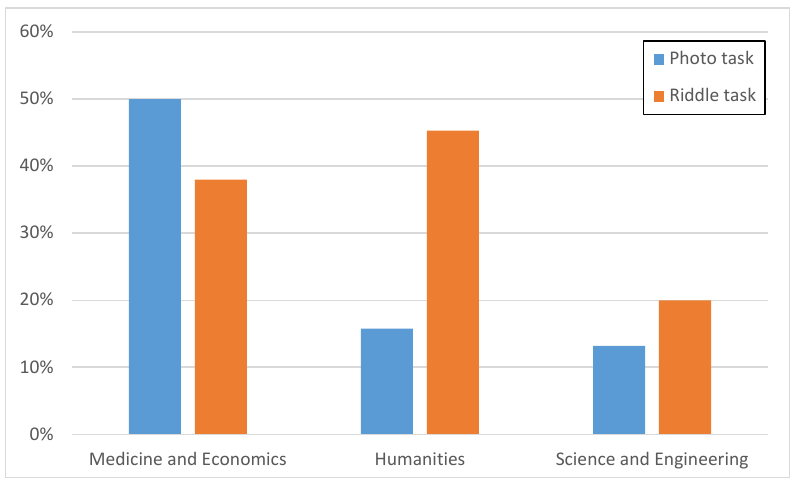
Figure 11. Ratio of success by users’ university course.